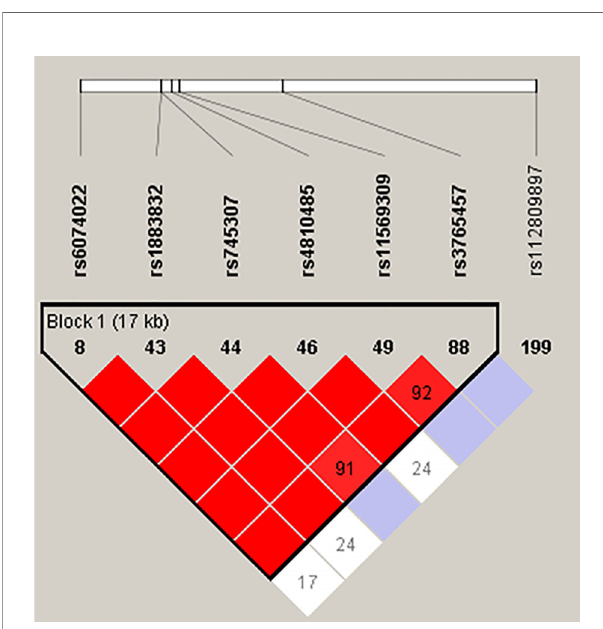
FIGURE 1 | Haploview map of the seven CD40 SNPs analyzed in this study. The color scheme of the LD map ranges from white to red, with red indicating tight LD with a D ’ of 1.